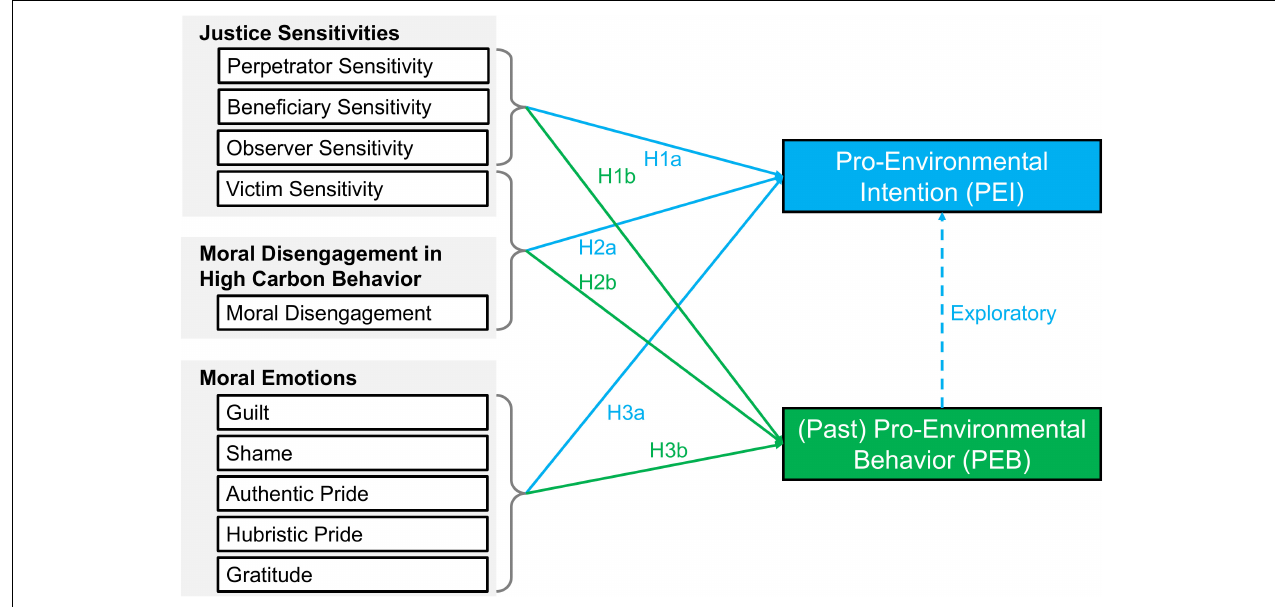
FIGURE 1 | Hypotheses 1–3 (a and b) of the current